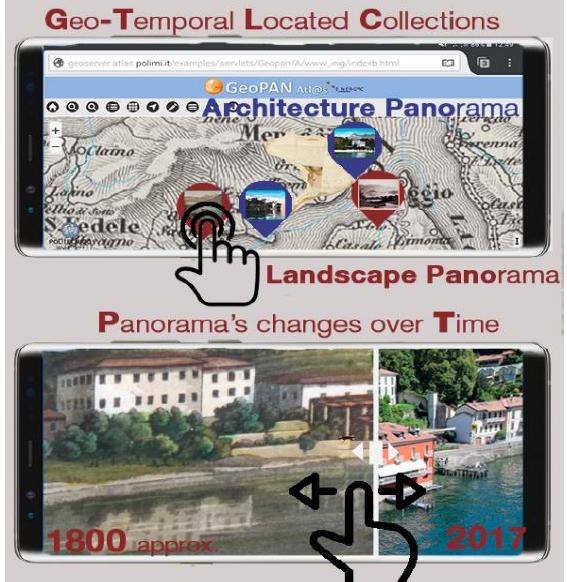
Figure 11. The GeoPAN APP can be customized to